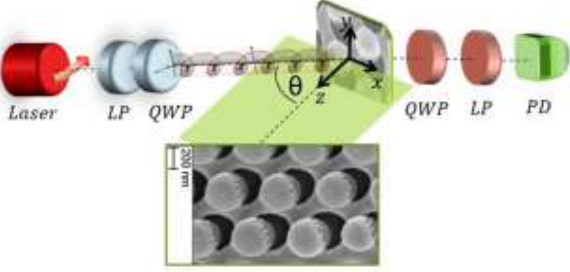
Fig. 1 Set-up of the chiro-optical characterization with both input and output beams resolved in polarization. Inset : SEM image of the investigated sample.